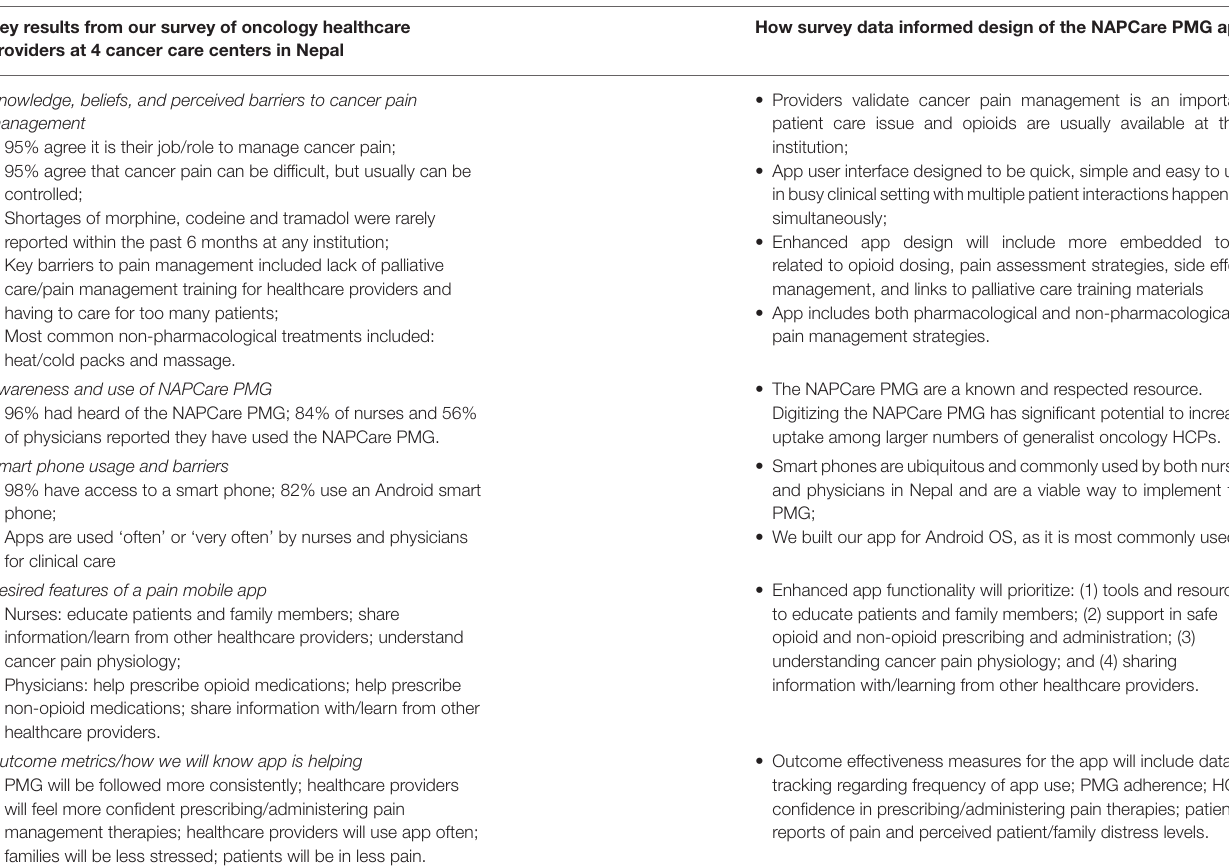
TABLE 3 | Selected survey results that informed design of the mobile